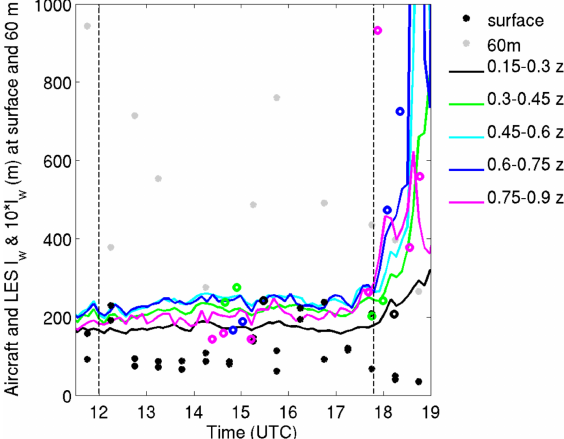
Figure 11. Temporal evolution of l w calculated from the KL89 an- alytical model fit on LES (continuous lines), aircraft (open circles) and surface (closed circles) spectra at different heights (different colours). Note that l w at surface and at 60m is multiplied by a fac- tor of 10. The vertical dashed lines stand for the times of maxi- mum surface buoyancy flux (at 12:00UTC) and its zero value (at 17:50UTC).